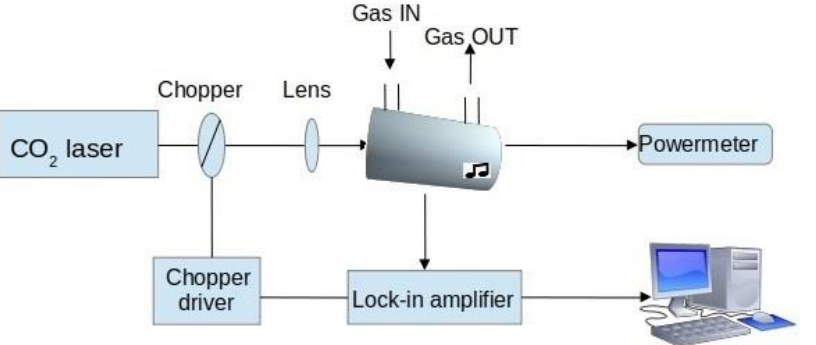
Figure 2. SchematicrepresentationoftheCO 2 Figure 2. Schematic representation of the CO 2 LPAS detector used for environmental ammonia measurements.